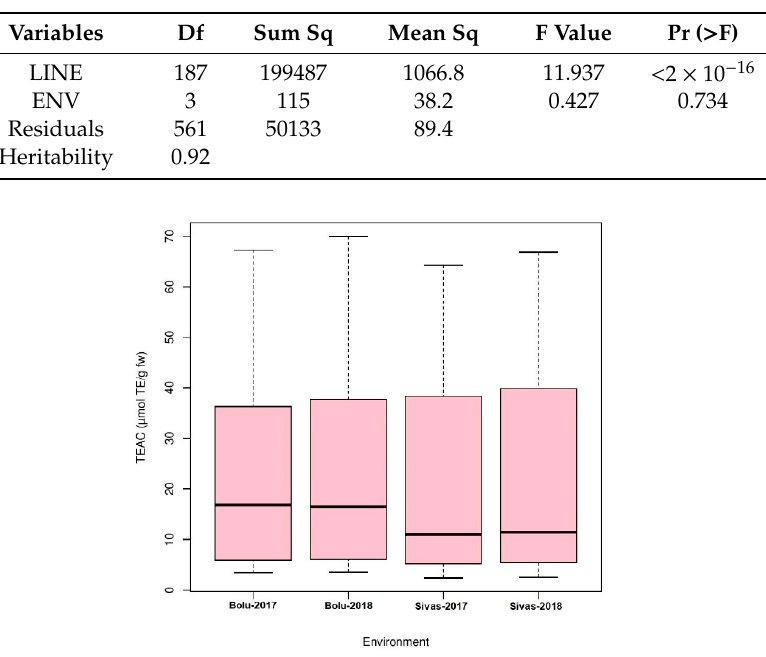
Figure 2. Boxplot analysis of antioxidant activity in Turkish common bean germplasm under four environments .